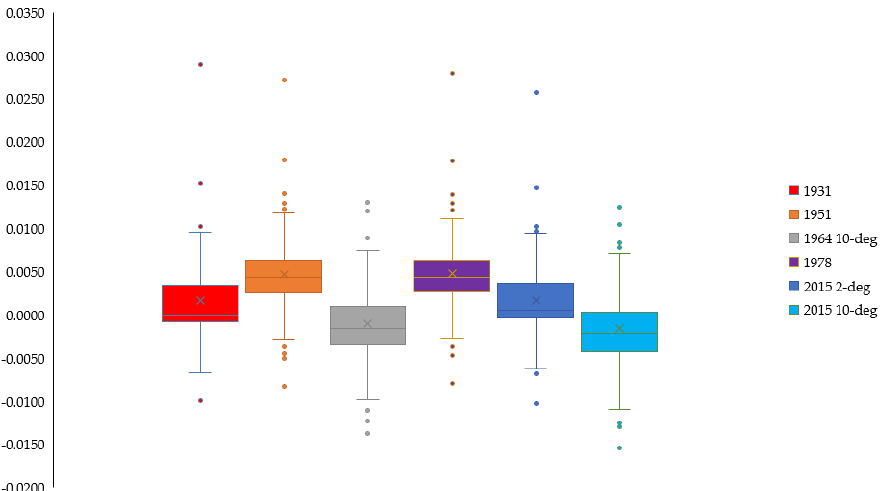
Figure 6. The box plot of D uv for six CMFs: 1931 (red), 1951 (orange), 1964 10-degrees (gray), 1978 (purple), 2015 2-degrees (blue), 2015 10-degrees (cyan) . Table 7. Rank sum test and effect size for CCT ( p -value and effect size ( r )) .